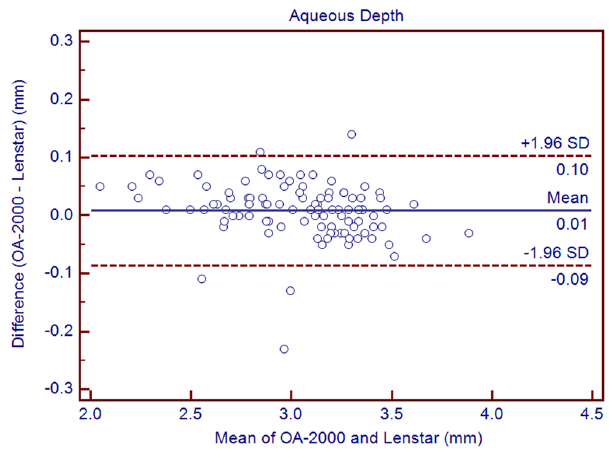
Figure 6. Bland-Altman plots show the agreement between OA-2000 swept-source optical coherence tomography and Lenstar optical low coherence reflectometry for measuring aqueous depth. Solid lines represent the bias between both devices and dotted lines represent the 95% confidence interval for the